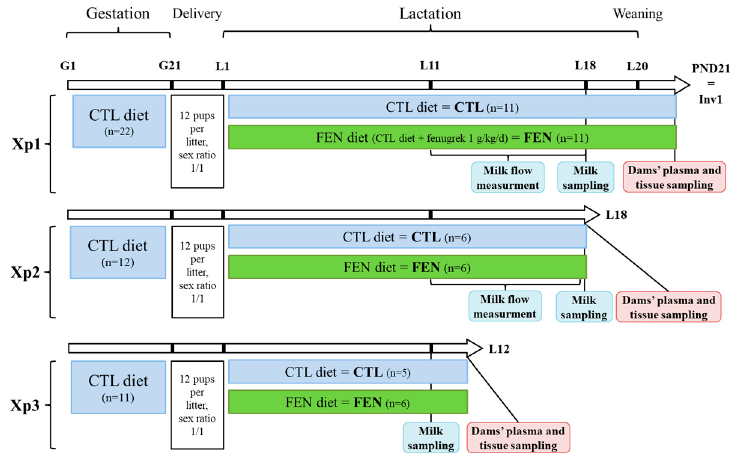
Figure 1. Experimental design: three series of animal experiments (Xp1, 2 and 3) were carried out, all with dams receiving either control (CTL) or fenugreek-supplemented diet (FEN), with different period of sampling for each experiment. G, L, PND and Inv correspond to the day of gestation, lactation, post-natal and involution days, respectively. Milk flow was measured by the deuterated water enrichment method [14,15] between L11 and L18. Tissues sampled were mammary and pituitary glands.